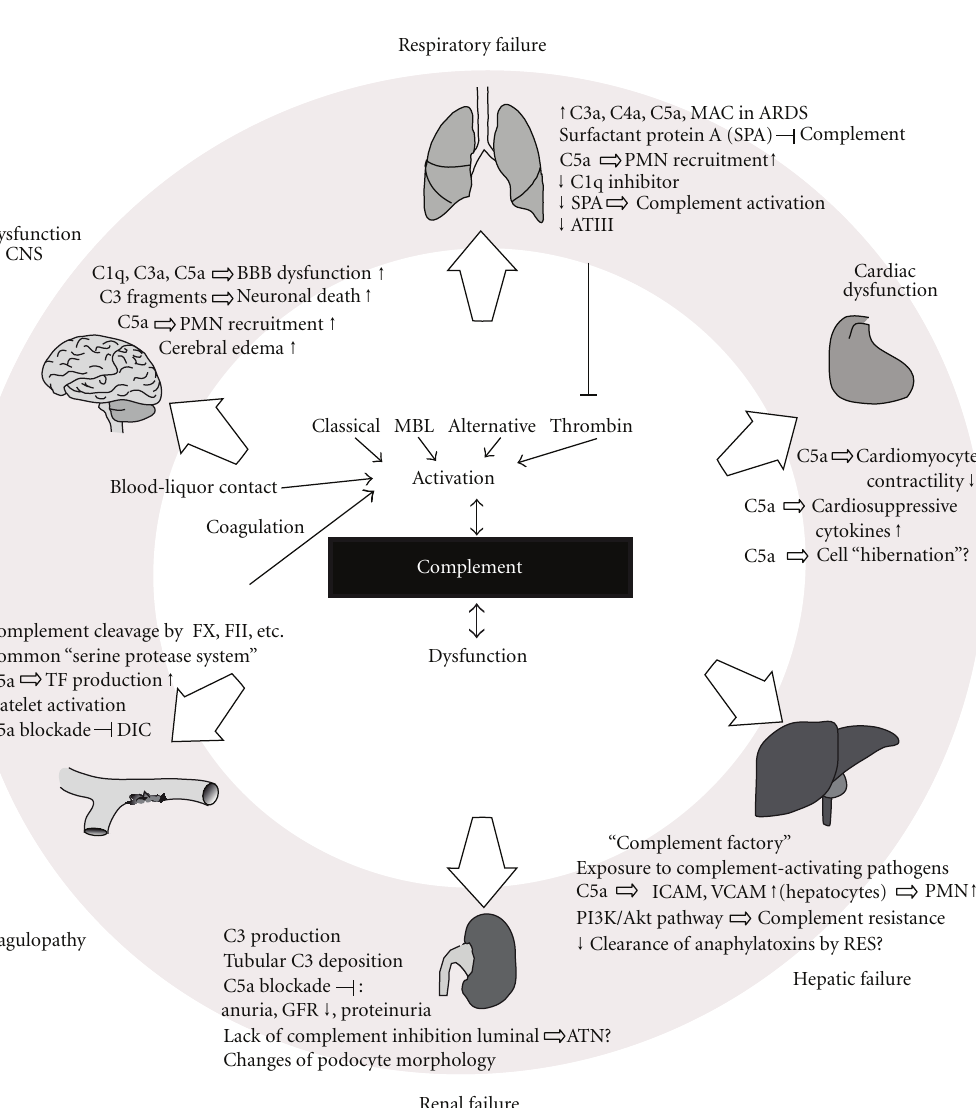
Figure 1: Summarizing illustration on the e ff ects of excessive complement activation on various organ systems and the development of organ failure. For details see text. MBL: mannose-binding lectin, CNS: central nervous system, BBB: blood brain barrier, PMN: polymorphonuclear neutrophils, ARDS: acute respiratory distress syndrome, ATIII: antithrombin III, RES: reticuloendothelial system, GFR: glomerular filtration rate, ATN: acute tubular necrosis, FX: coagulation factor X, FII: coagulation factor II, TF: tissue factor, DIC: disseminated intravascular